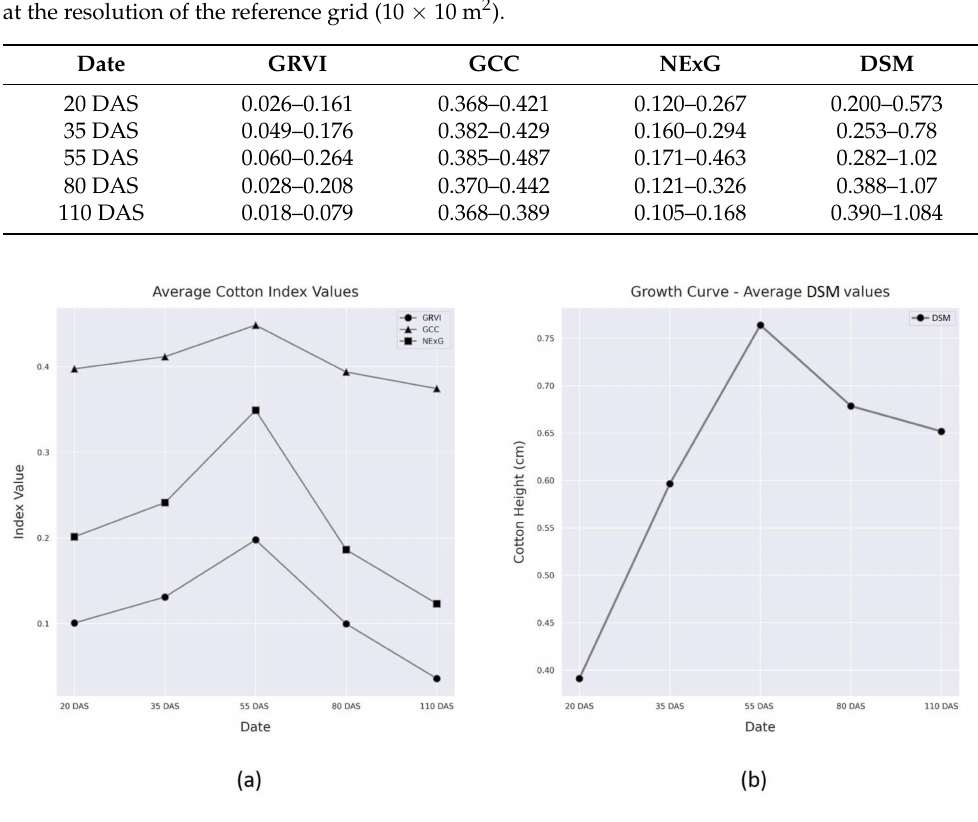
Figure 12. The VI values ( a ) and cotton horizontal growth curve (DSM values) ( b ) throughout the